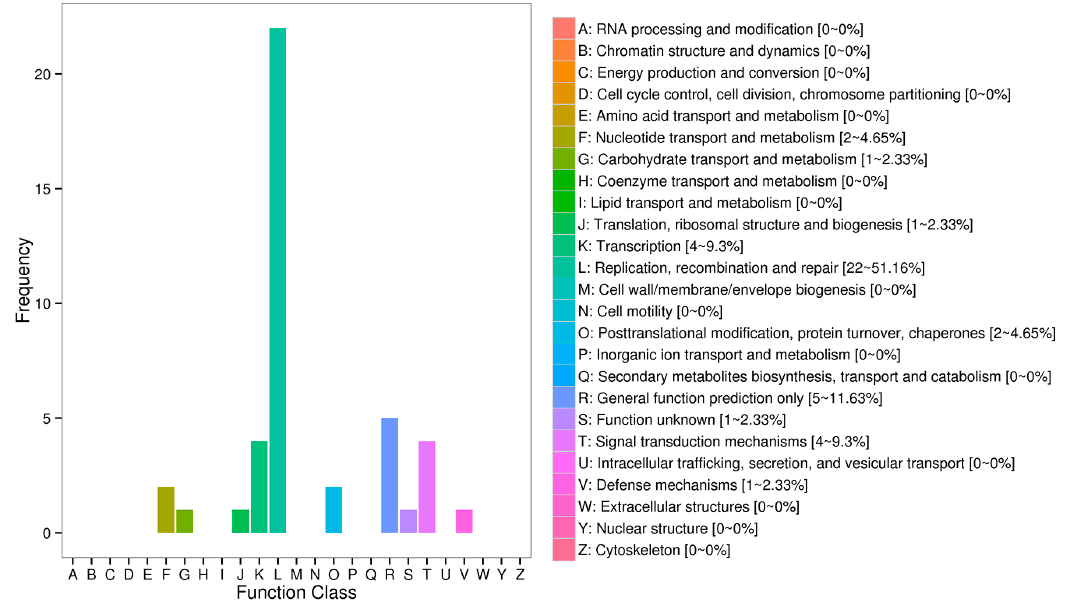
Figure 2. COG classifications of DEGs associating with feed conversion efficiency from brain samples of crucian carp.